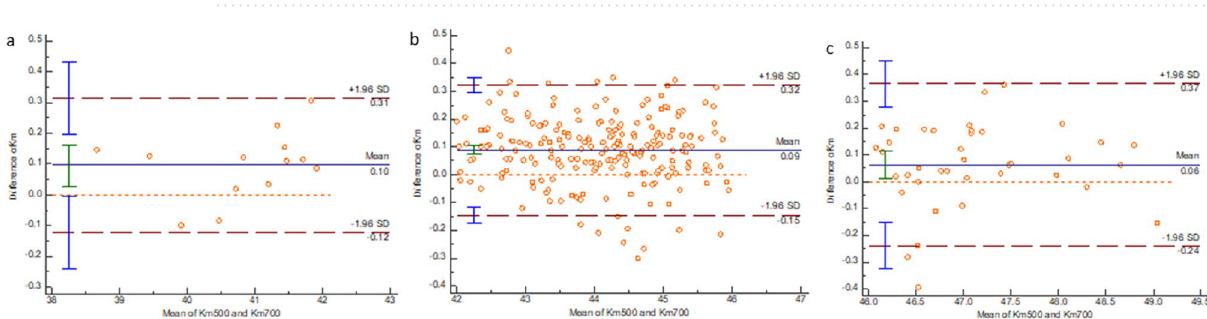
Figure 2. Bland–Altman plot showing the results of Km measurement by the two instruments. ( a ) Km < 42.00 D group. ( b ) 42.00 D ≤ Km ≤ 46.00 D group. ( c ) Km > 46.00 D